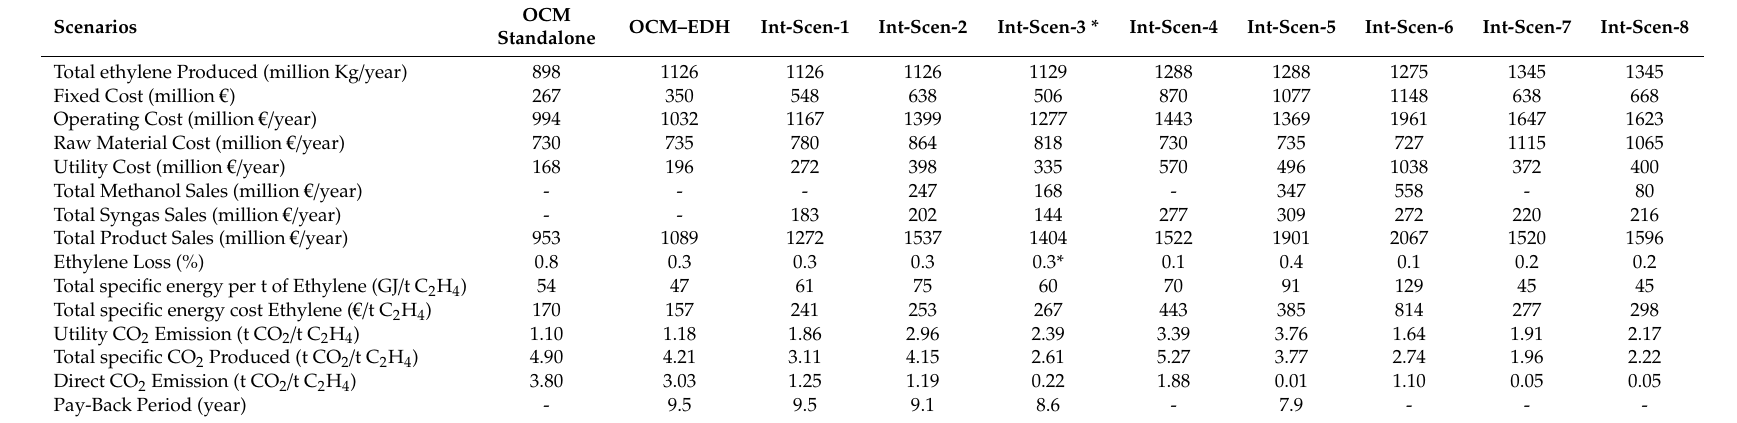
Table 5. Economic performance indicators of the investigated process scenarios (pre-specified in Table